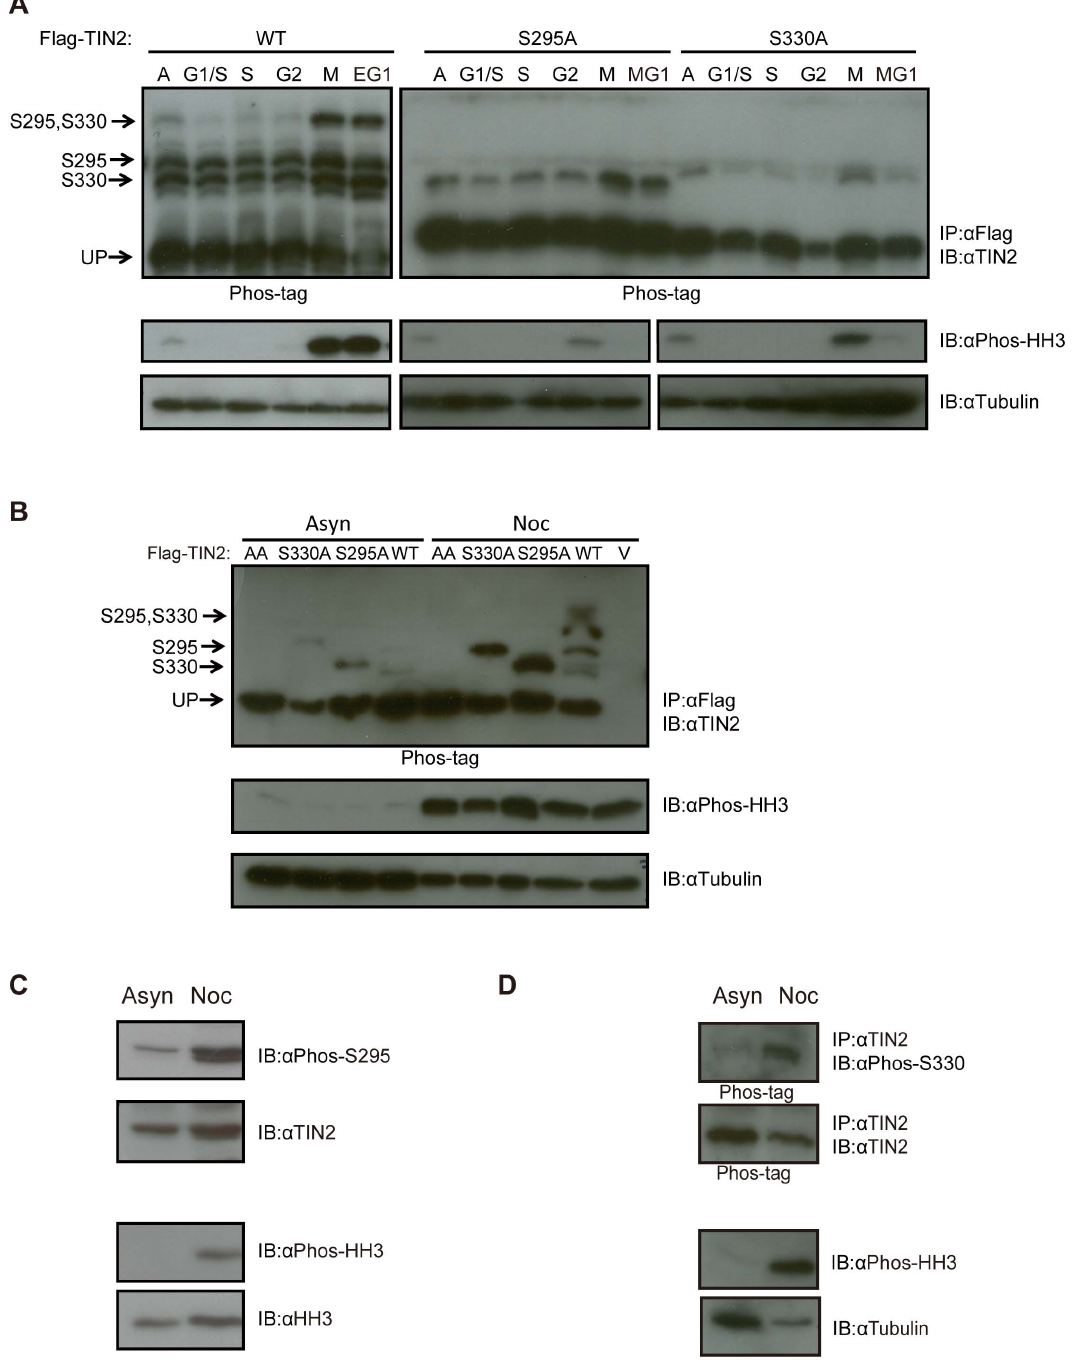
Figure 2. TIN2 is phosphorylated on S295 and S330 during mitosis. ( A ) Detection of S295 and S330 phosphorylation of TIN2 during mitosis by the Phos-tag reagent after release from a double thymidine block. HeLa cells stably infected with a retrovirus encoding Flag-TIN2 in the WT, S330A, or S295A configuration were collected from asynchronous populations (A), populations arrested with a double thymidine block corresponding to the G1/S phase of the cell cycle, or populations at the points corresponding to S, G2, M and early or middle G1 (EG1 or MG1) after release from the double thymidine block. Derived lysates were then either subjected to ( top ) immunoprecipitation (IP) with an anti-Flag antibody and resolved by SDS-PAGE in the presence of the Phos-tag reagent and immunoblotted (IB) with an anti-TIN2 antibody or ( bottom ) resolved by normal SDS-PAGE and immunoblotted with either an anti-Phos-HH3 antibody to monitor cell cycle progression or an anti-Tubulin antibody as a loading control. The supershifted bands corresponding to S295, S330, or S295 and S330 phosphorylation, as well as the unphosphorylated TIN2 (UP) are denoted on the left of the upper panels. Left and right panels are different exposures. Representative of two experiments. ( B ) Detection of S295 and S330 phosphorylation of TIN2 by the Phos-tag reagent in cells arrested with nocodazole. HeLa cells stably infected with a retrovirus encoding no transgene (vector, V) or Flag-TIN2 in the WT, S330A, S295A, or AA configuration were collected from asynchronous populations (Asyn) or populations arrested in G2/M by treatment with nocodazole (Noc). Derived lysates were then subjected to either ( top ) immunoprecipitation (IP) with a Flag and